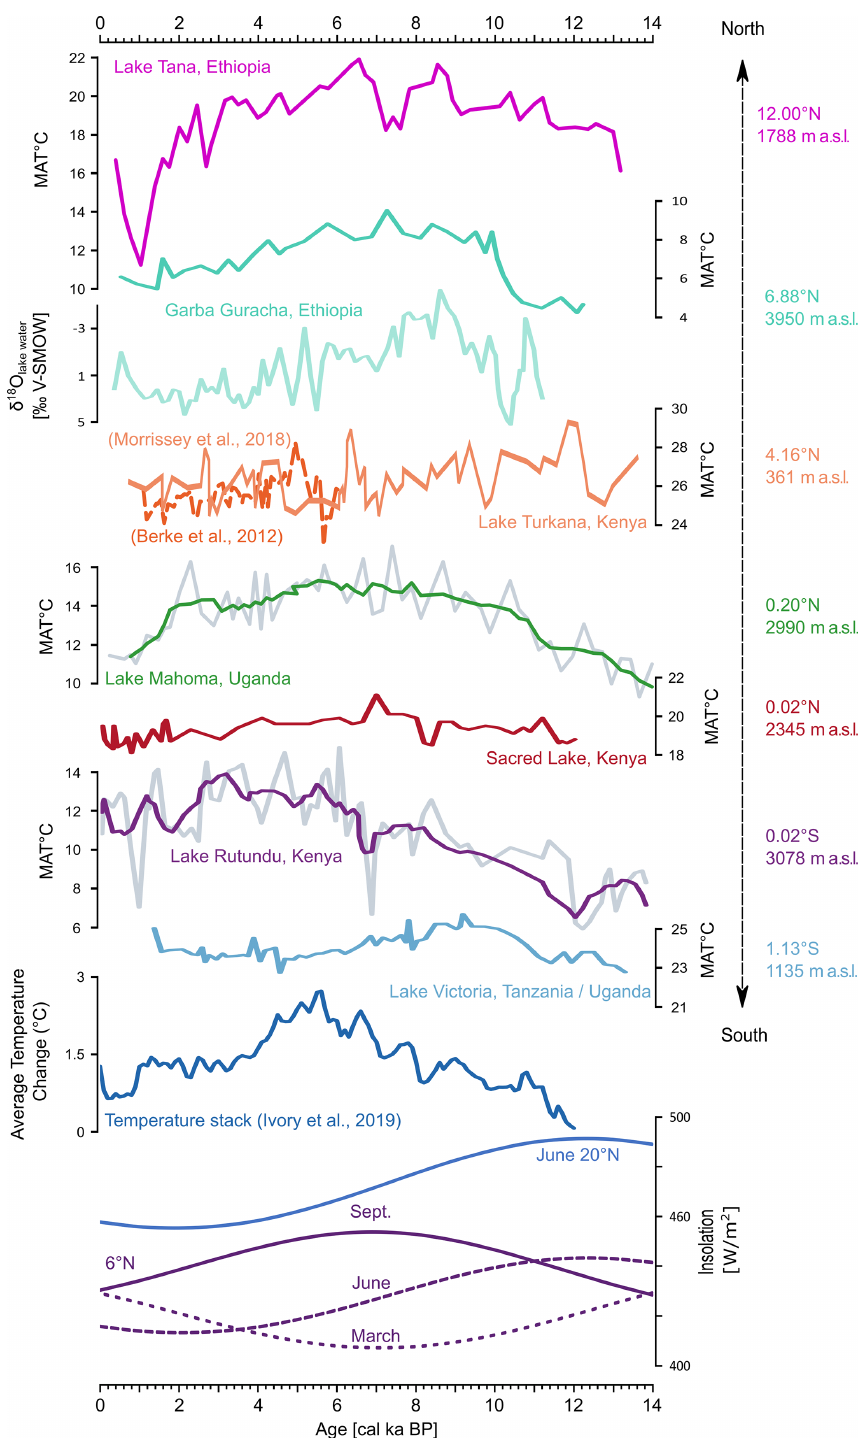
Figure 8. Comparison of records. MAT: Lake Tana (Loomis et al., 2015), Garba Guracha (this study), δ 18 O lake water as reconstructed from the aquatic sugar biomarker fucose (Bittner et al., 2021), Lake Turkana (Berke et al., 2012b; Morrissey et al., 2018), Lake Mahoma (Garelick et al., 2022), Sacred Lake (Loomis et al., 2012), Lake Rutundu (Loomis et al., 2017), Lake Victoria (Berke et al., 2012a), eastern Africa temperature stack (Ivory and Russell, 2018), and insolation 6 ◦ N and June 20 ◦ N (Laskar et al., 2004).